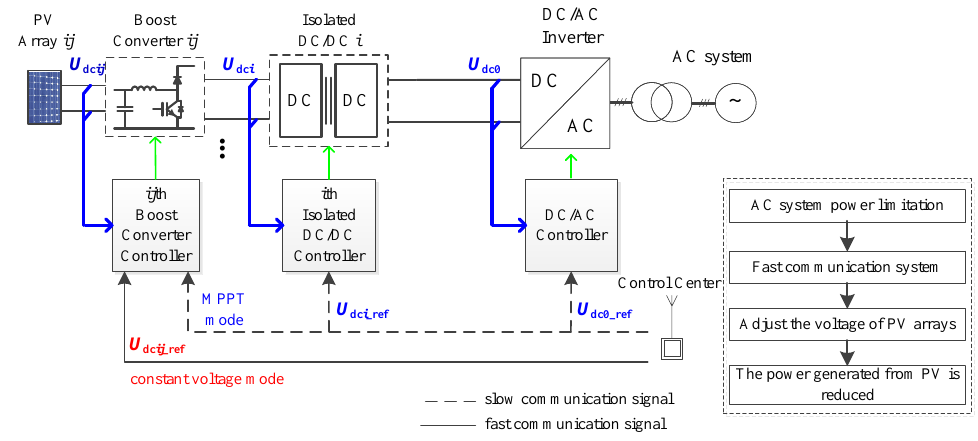
Figure 8. Conventional control scheme of PV integration system.